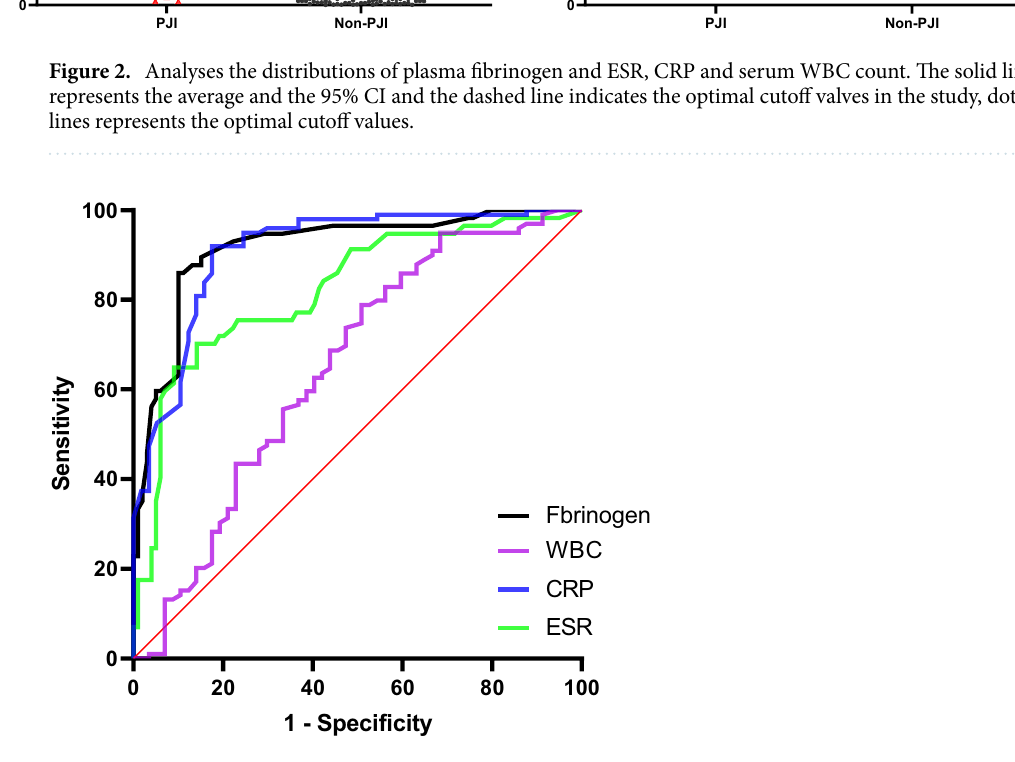
Figure 3. The ROC curves of plasma fibrinogen, ESR, CRP and serum WBC count for the diagnosis of